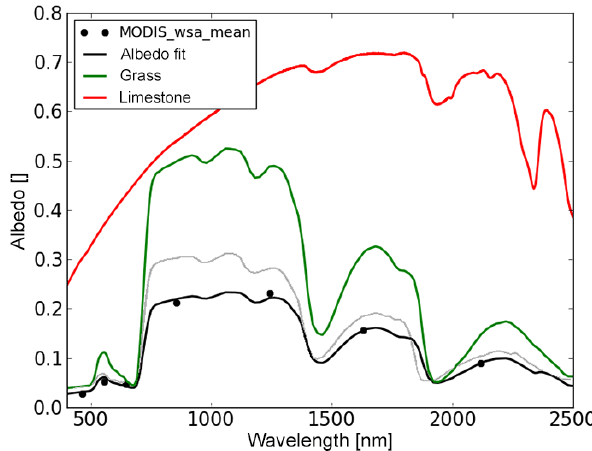
Figure 2. Interpolation of MODIS white-sky albedo (black points) with ASTER spectral albedo of grass (green line) and limestone (red line). Spectral surface albedo for the area around UFS (black line) resulting from the fit A = 0 . 39 · A grass + 0 . 05 · A limestone . In light grey the spectral surface albedo for Munich is shown which is used in the sensitivity